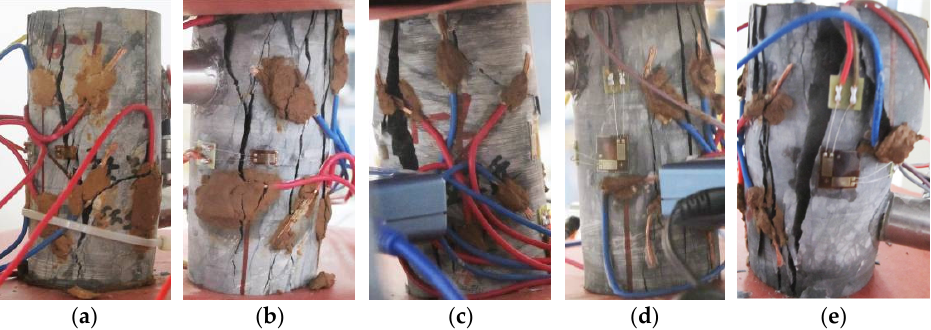
Figure 5. Failure state of rock samples parallel to the bedding direction. ( a ) Rock sample 6 ‐ 1; ( b ) Rock sample 6 ‐ 5; ( c ) Rock sample 7 ‐ 1; ( d ) Rock sample 7 ‐ 2; ( e ) Rock sample 7 ‐ 3.